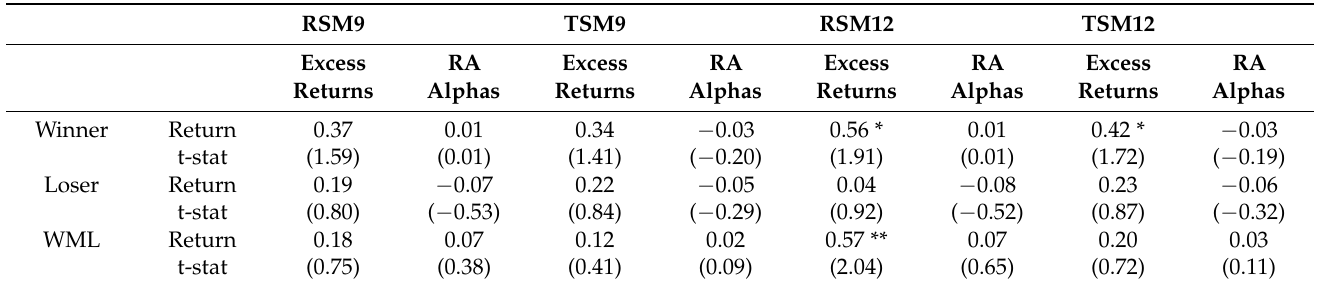
Table 3. Descriptive statistics of conventional static momentum and economic policy uncertainty.